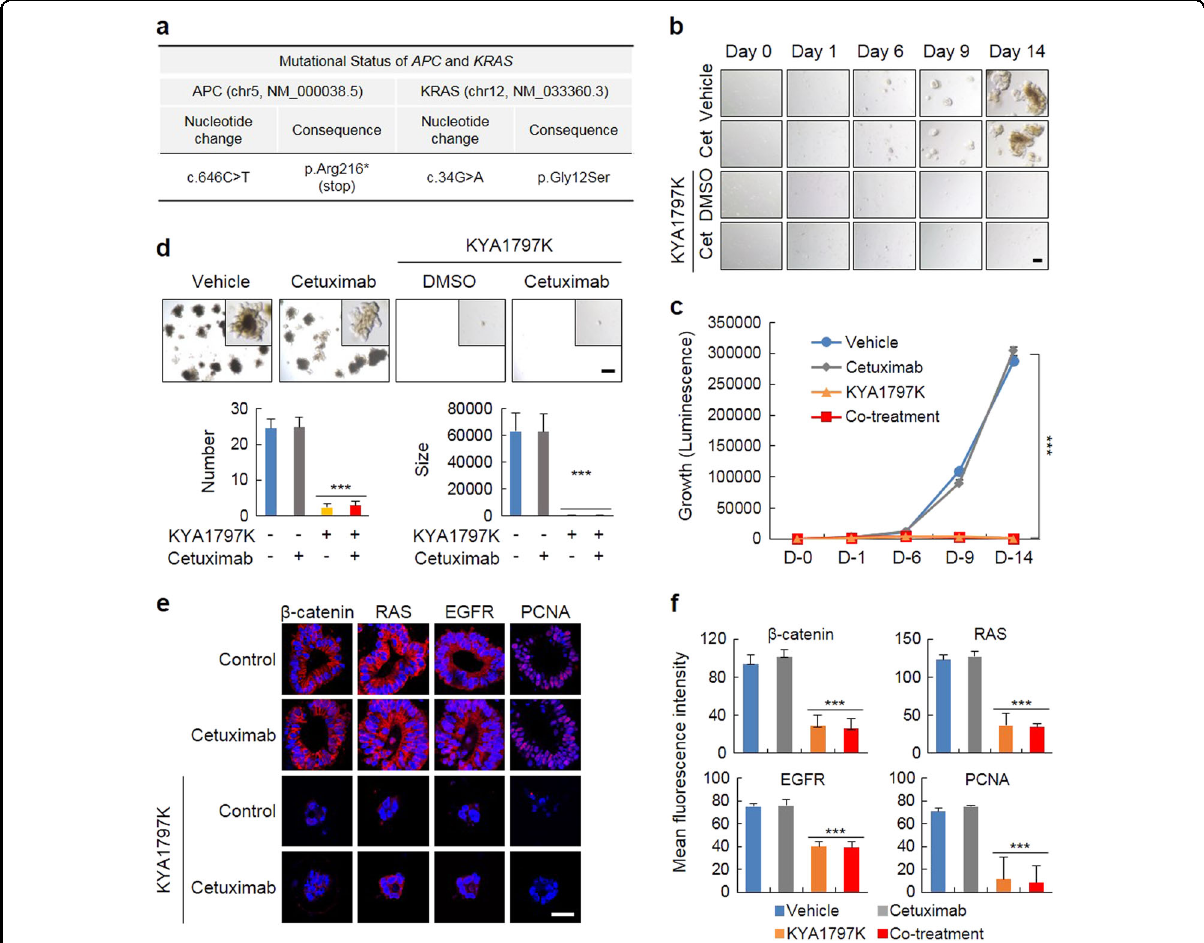
Fig. 6 KYA1797K effectively suppresses the formation and growth of tumor organoids derived from CRC patients having both APC and KRAS mutations. a The tumor organoids derived from the CRC patient tissue were cultured as described in the materials and methods section and analyzed by whole exome sequencing to determine the mutational status of the genes of interest, including KRAS and APC . b , c The tumor organoids were treated under the indicated conditions for 14 days. The tumor organoids were visualized ( b , scale bar, 200 µm), and the growth of the tumor organoids was measured by a cell titer assay ( c ). d Images of the tumor organoids treated with the indicated conditions for 21 days were captured at low magni fi cation (upper panel, scale bar, 1 mm), and high-magni fi cation images were visualized in the boxed region (inset). The number and size of the tumor organoids were quanti fi ed ( d , lower panel). e ICC analysis of β -catenin, pan-RAS, EGFR, or PCNA in the tumor organoids cultured under the indicated conditions for 14 days. The tumor organoids were immobilized and then immunostained with antibodies. Scale bar, 50 µm. f The levels of these proteins were measured by the mean fl uorescence intensity. The data are presented as the mean ± SD ( n = 3). Two-sided Student ’ s t- test, *** P <